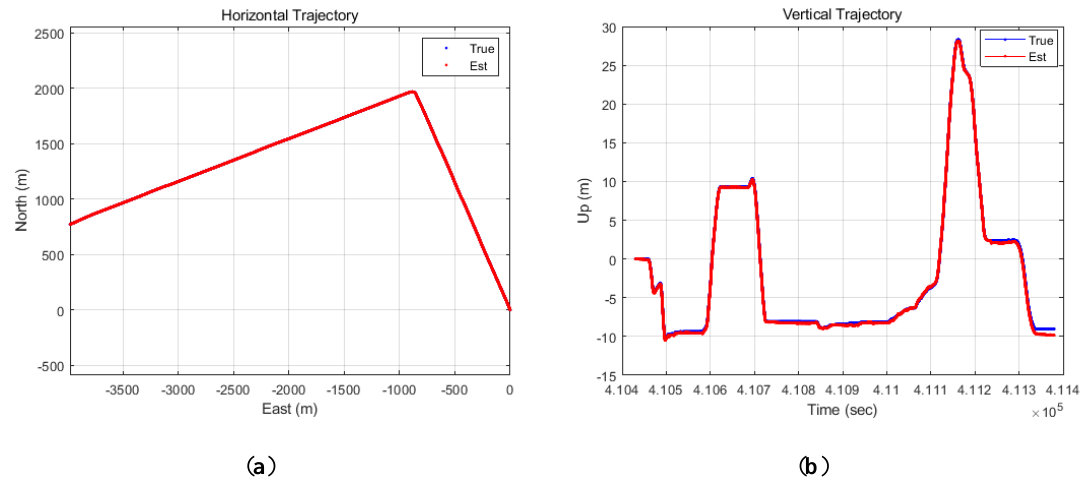
Figure 10. ( a ) Horizontal trajectory; ( b ) vertical trajectory (TDCP/INS).